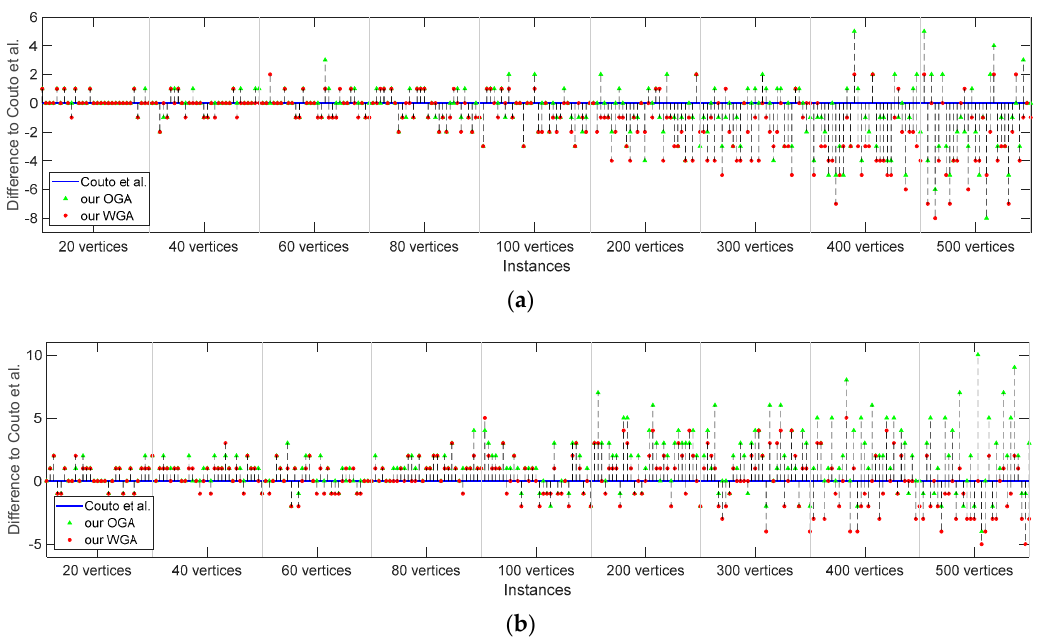
Figure 9. Difference in the number of optimal viewpoints between Couto et al. and our methods for ( a ) random orthogonal polygons; ( b ) random simple polygons.